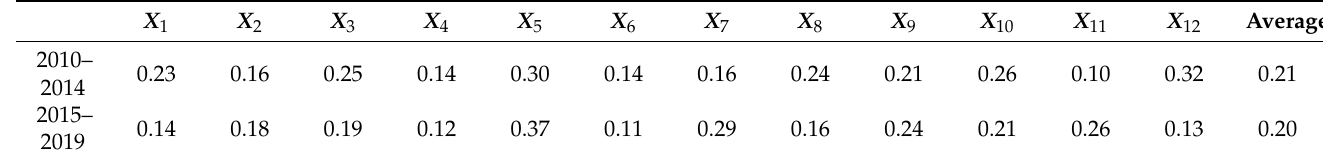
Table 8. Analysis of the evolution mode of independent variables in 2015–2019.